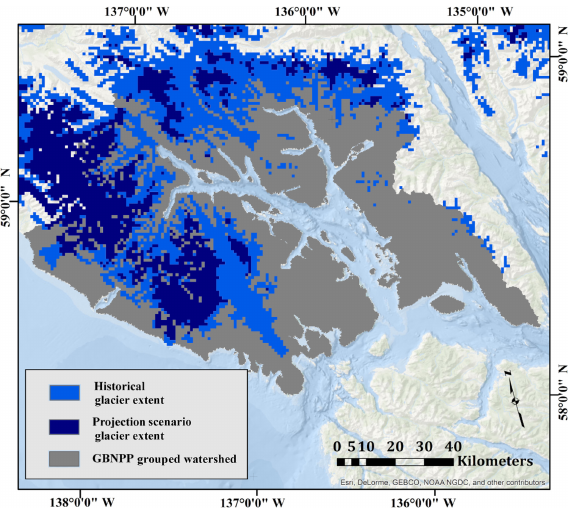
Figure 5. Glacier change map. Changes in glacier extent in the study area based on the Randolph Glacier Inventory (RGI) 2014 glacier locations for the historical period (1979–2015) and the + 400m change in equilibrium line altitude for the projection sce- nario (2070–2099) using RCP 8.5.